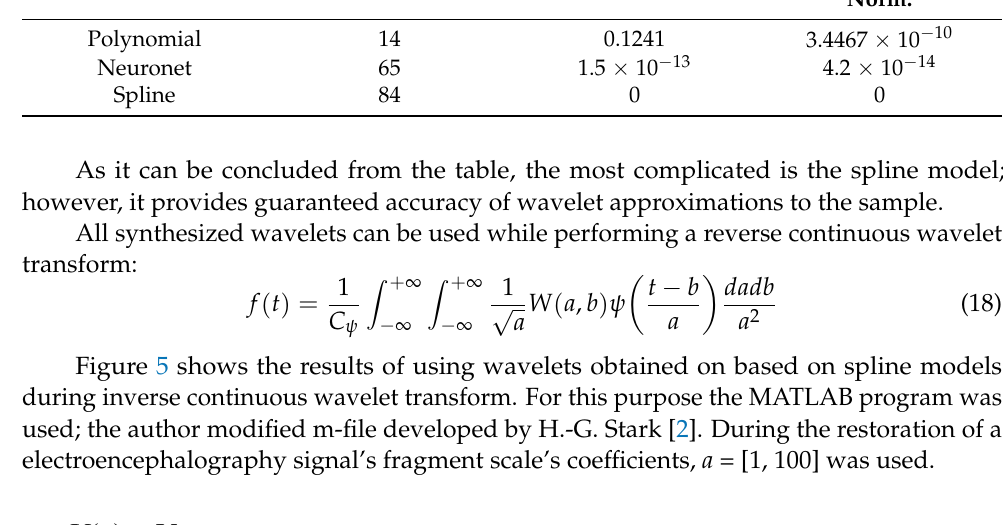
Table 2. The results of mathematical wavelet models obtained for analysis of broken signal’s study. Number of Models’ Mathematical Model Parameters Deviation, Norm.